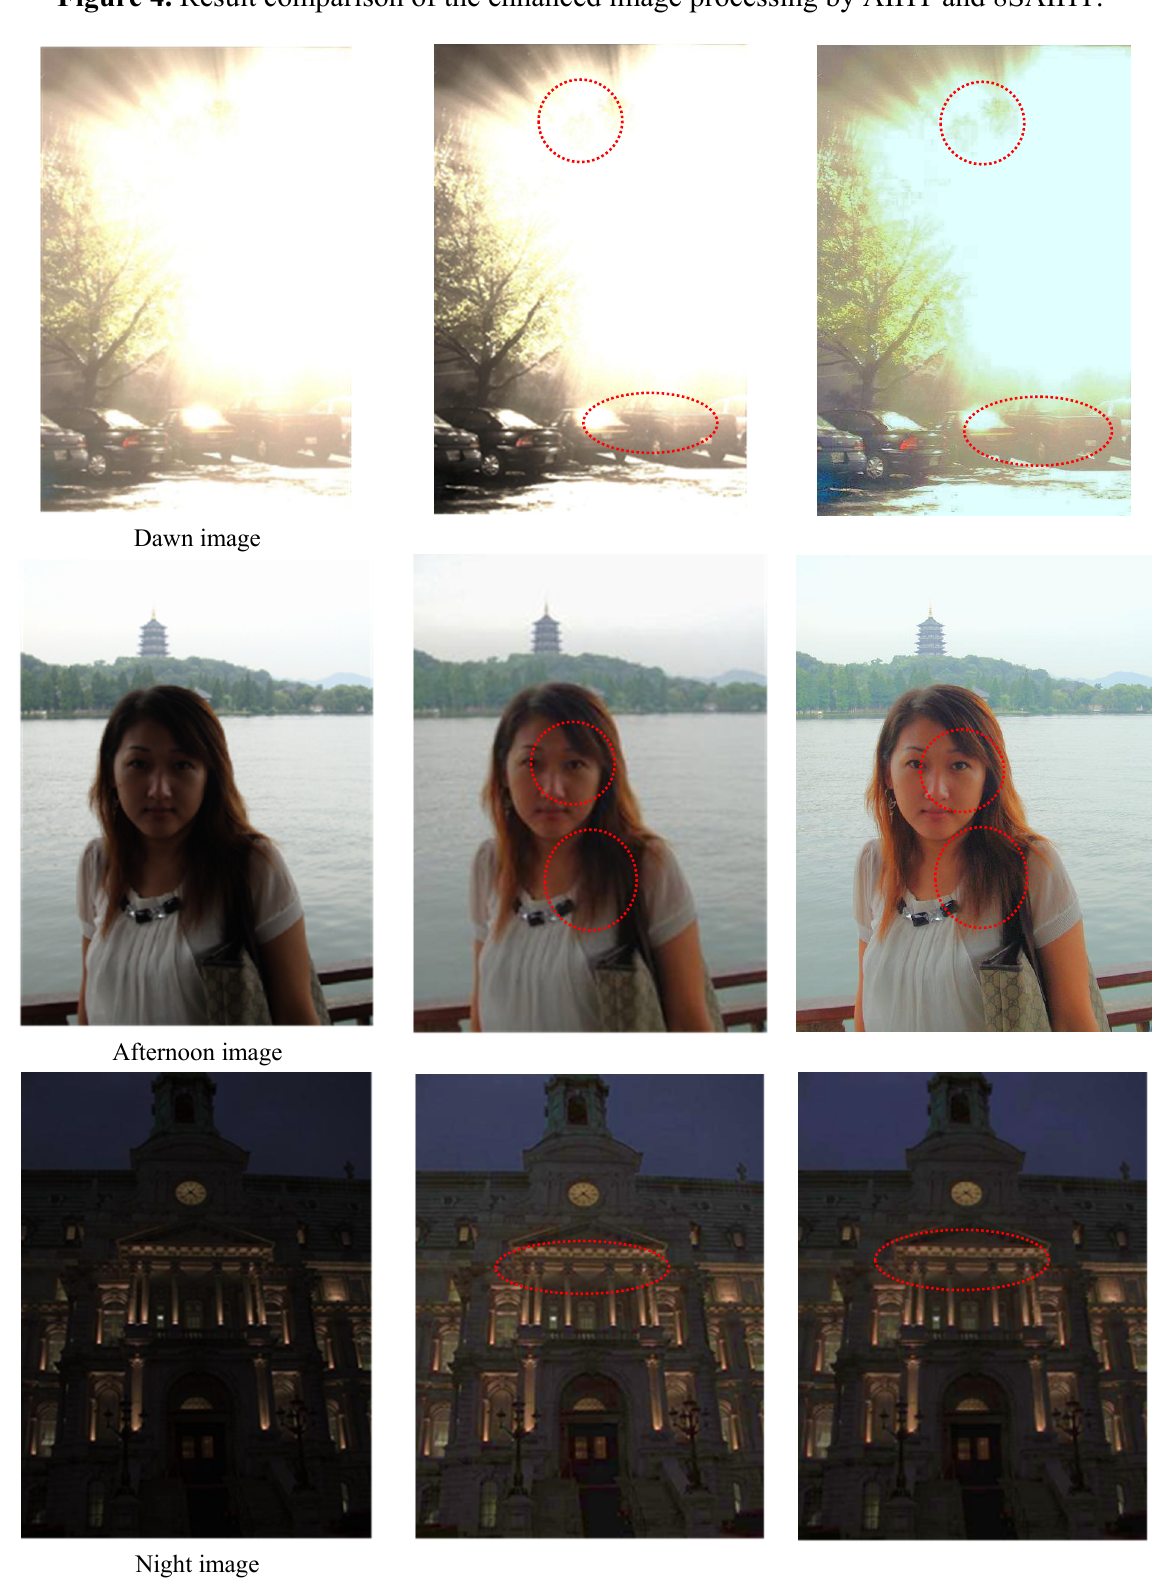
Figure 4. Result comparison of the enhanced image processing by AIHT and